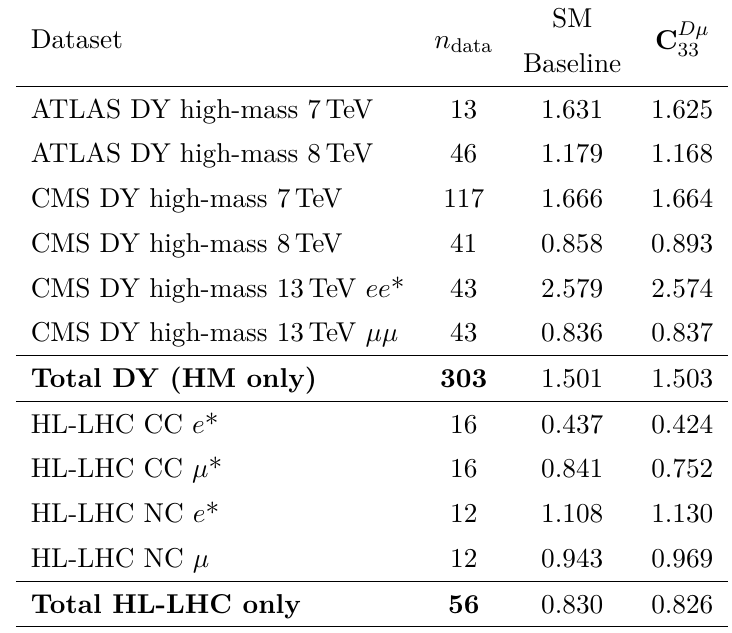
Table 6 . Values of the χ 2 per data point across all high mass Drell-Yan measurements. We tabulate values for the baseline PDF set as well as those obtained in the EFT scenario II. Shown also is the χ 2 for the HL-LHC projections. Quadratic terms in the EFT parameter are used in the χ 2 calculation. The rows indicating total χ 2 values are computed accounting for any relevant correlated systematic errors. Datasets marked with an asterisk indicate that they were not used to constrain C Dµ 33